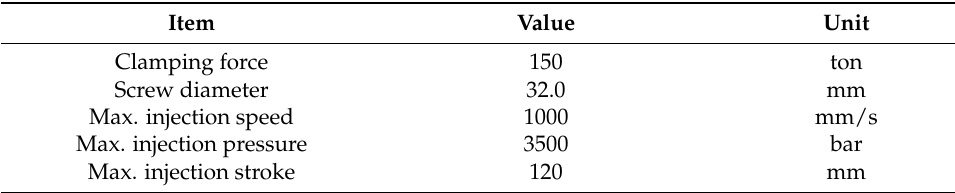
Table 3. Specifications of the injection molding machine (LGEII-150, LSMtron).